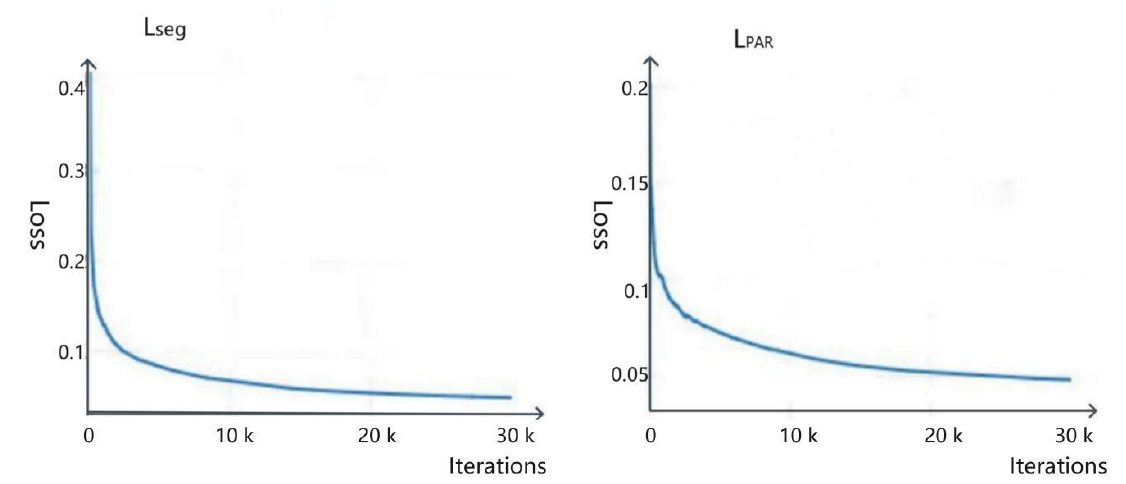
Figure 6. The training loss of the model.